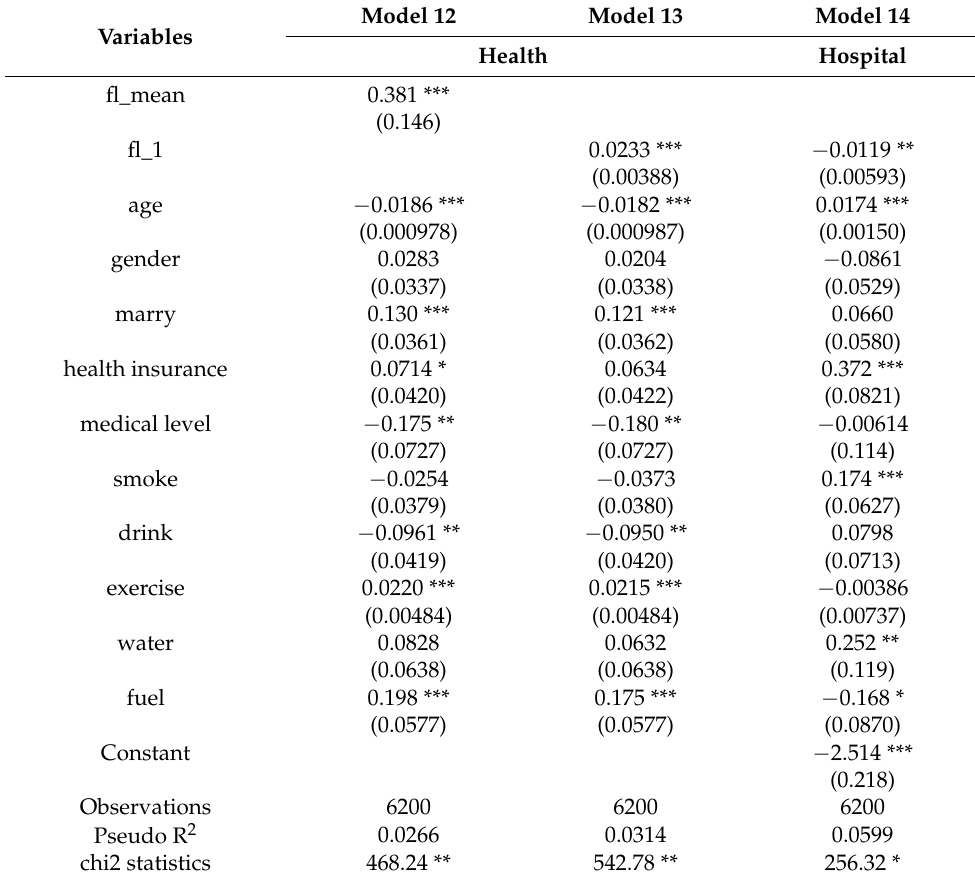
Table 7. Robustness